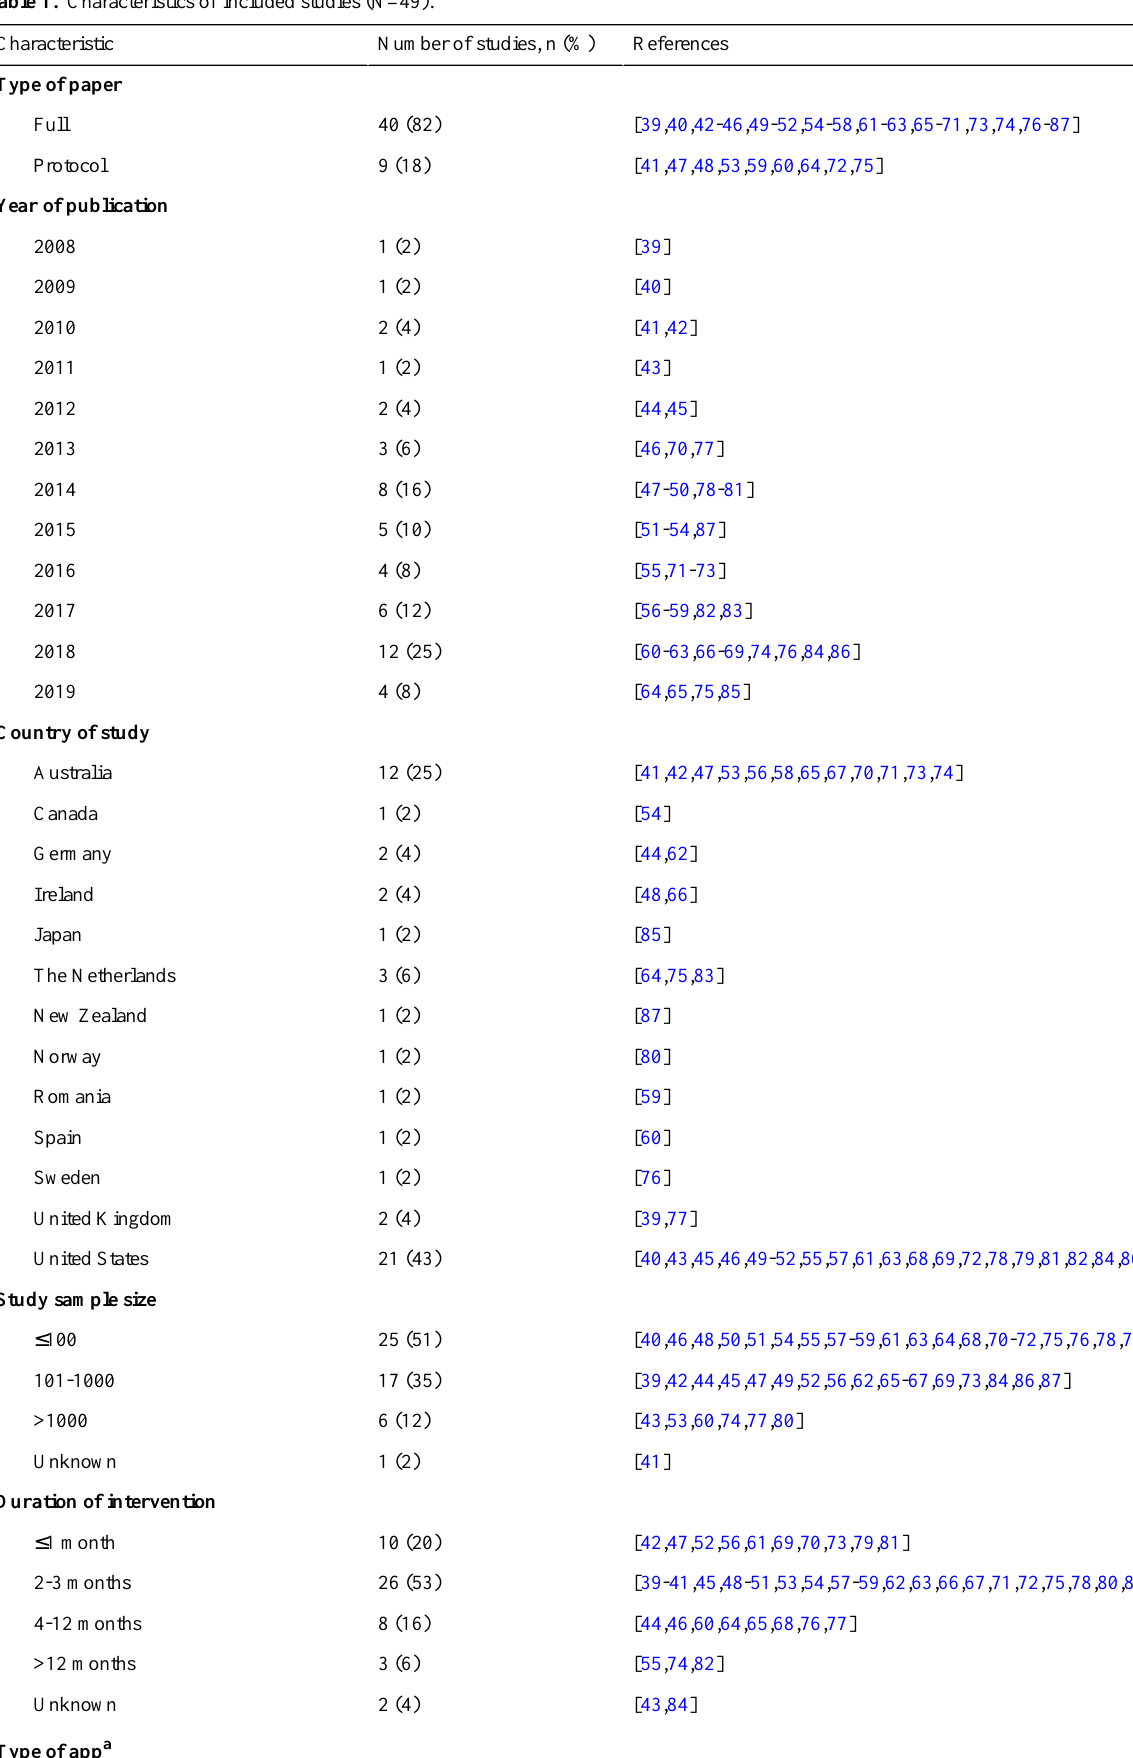
Table 1. Characteristics of included studies (N=49).